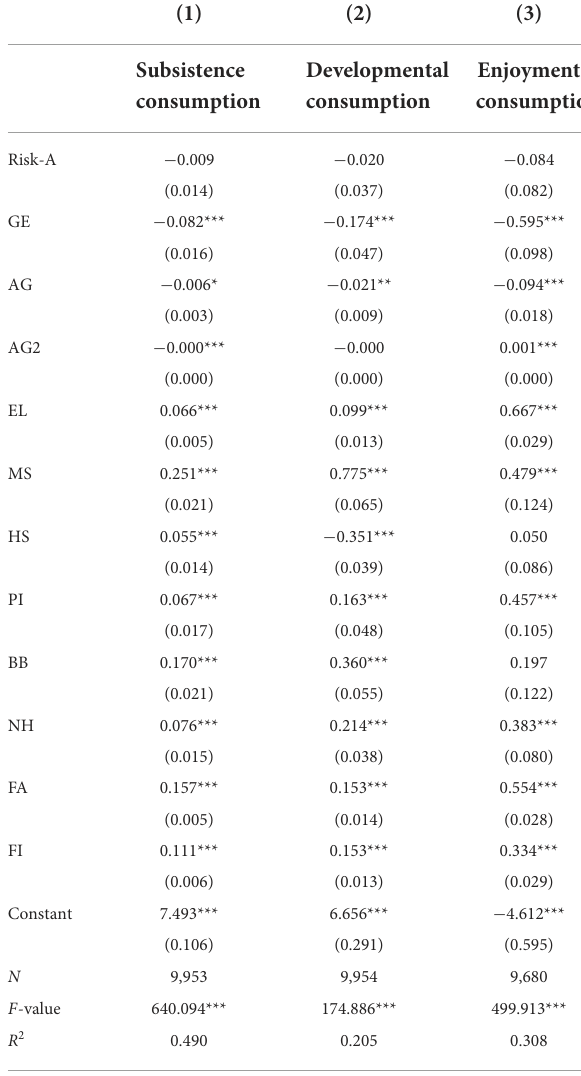
TABLE 6 The impact of risk aversion on different consumption types of